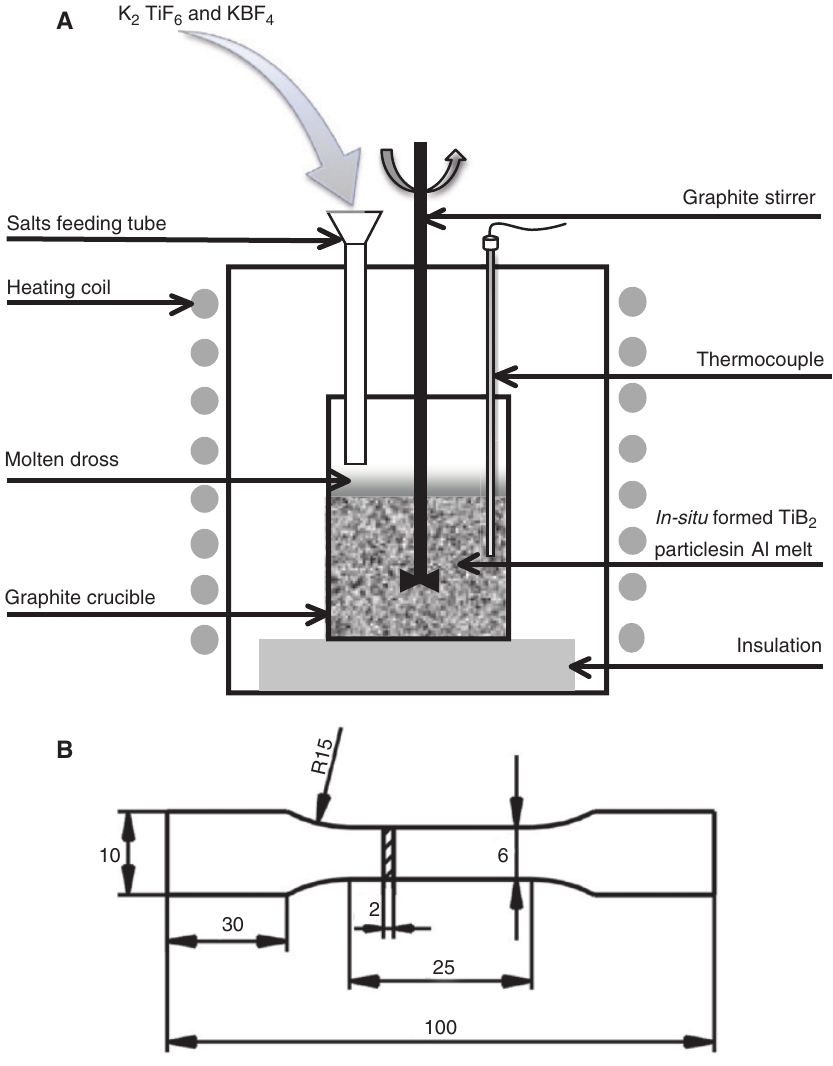
/Al-4.5Cu composite. (A) The schematic 2